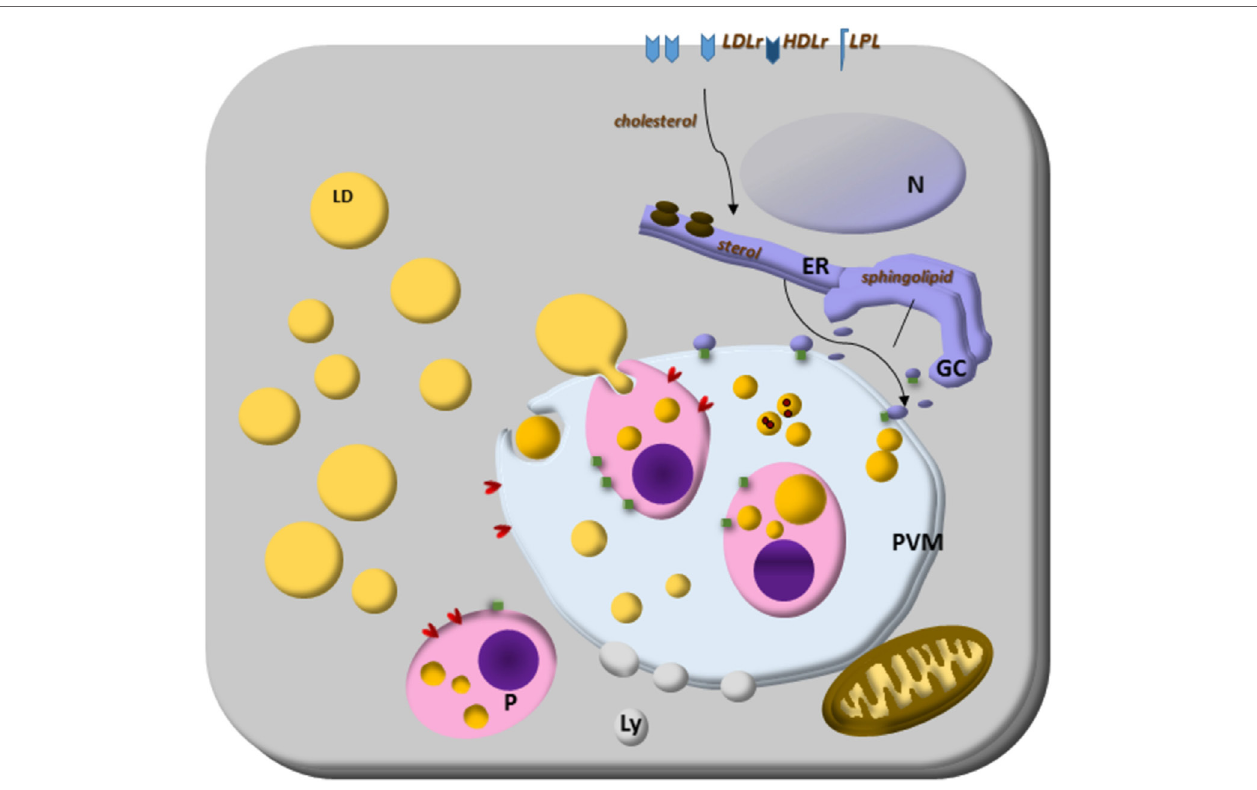
FiGURe 1 | Lipid droplets (LDs) on parasites lipid homeostasis. Trypanosoma spp., Leishmania spp., Plasmodium spp., and Toxoplasma gondii cannot synthesize cholesterol, and the energy and lipid source for them is the host lipid synthesis and host LDs, as well as low-density lipoproteins, eventually high-density lipoproteins particles and lipoprotein lipase. The close relationship with other organelles through Rab proteins can be lipid sources, such as endoplasmic reticulum (ER) for sterol and Golgi complex (GC) for sphingolipid sources. Although the mechanisms are still unknown, some parasites can store lipids on their LD. Lipoprotein- and ABC-proteins are involved in the mammalian lipid transport, as well as important enzymes to lipid synthesis like ACAT and DGAT proteins. These proteins are also present in T. gondii and ACAT-like proteins are present in Trypanosoma cruzi. The parasite transfer lipids to their own LD to be stored, but in Plasmodium spp., or they metabolize them as in Plasmodium and T. gondii . The parasite and host LDs are involved in essential cell functions that can favor the survival of the parasite, such as energy and lipid source for intracellular parasites proliferation. They also can isolate lipids or toxic metabolites from the cytoplasm for detoxification, such as hemozoin from heme on Plasmodium -infected cell